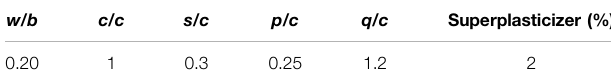
TABLE 5 | Optimal RPC mix proportion without steel fi ber.